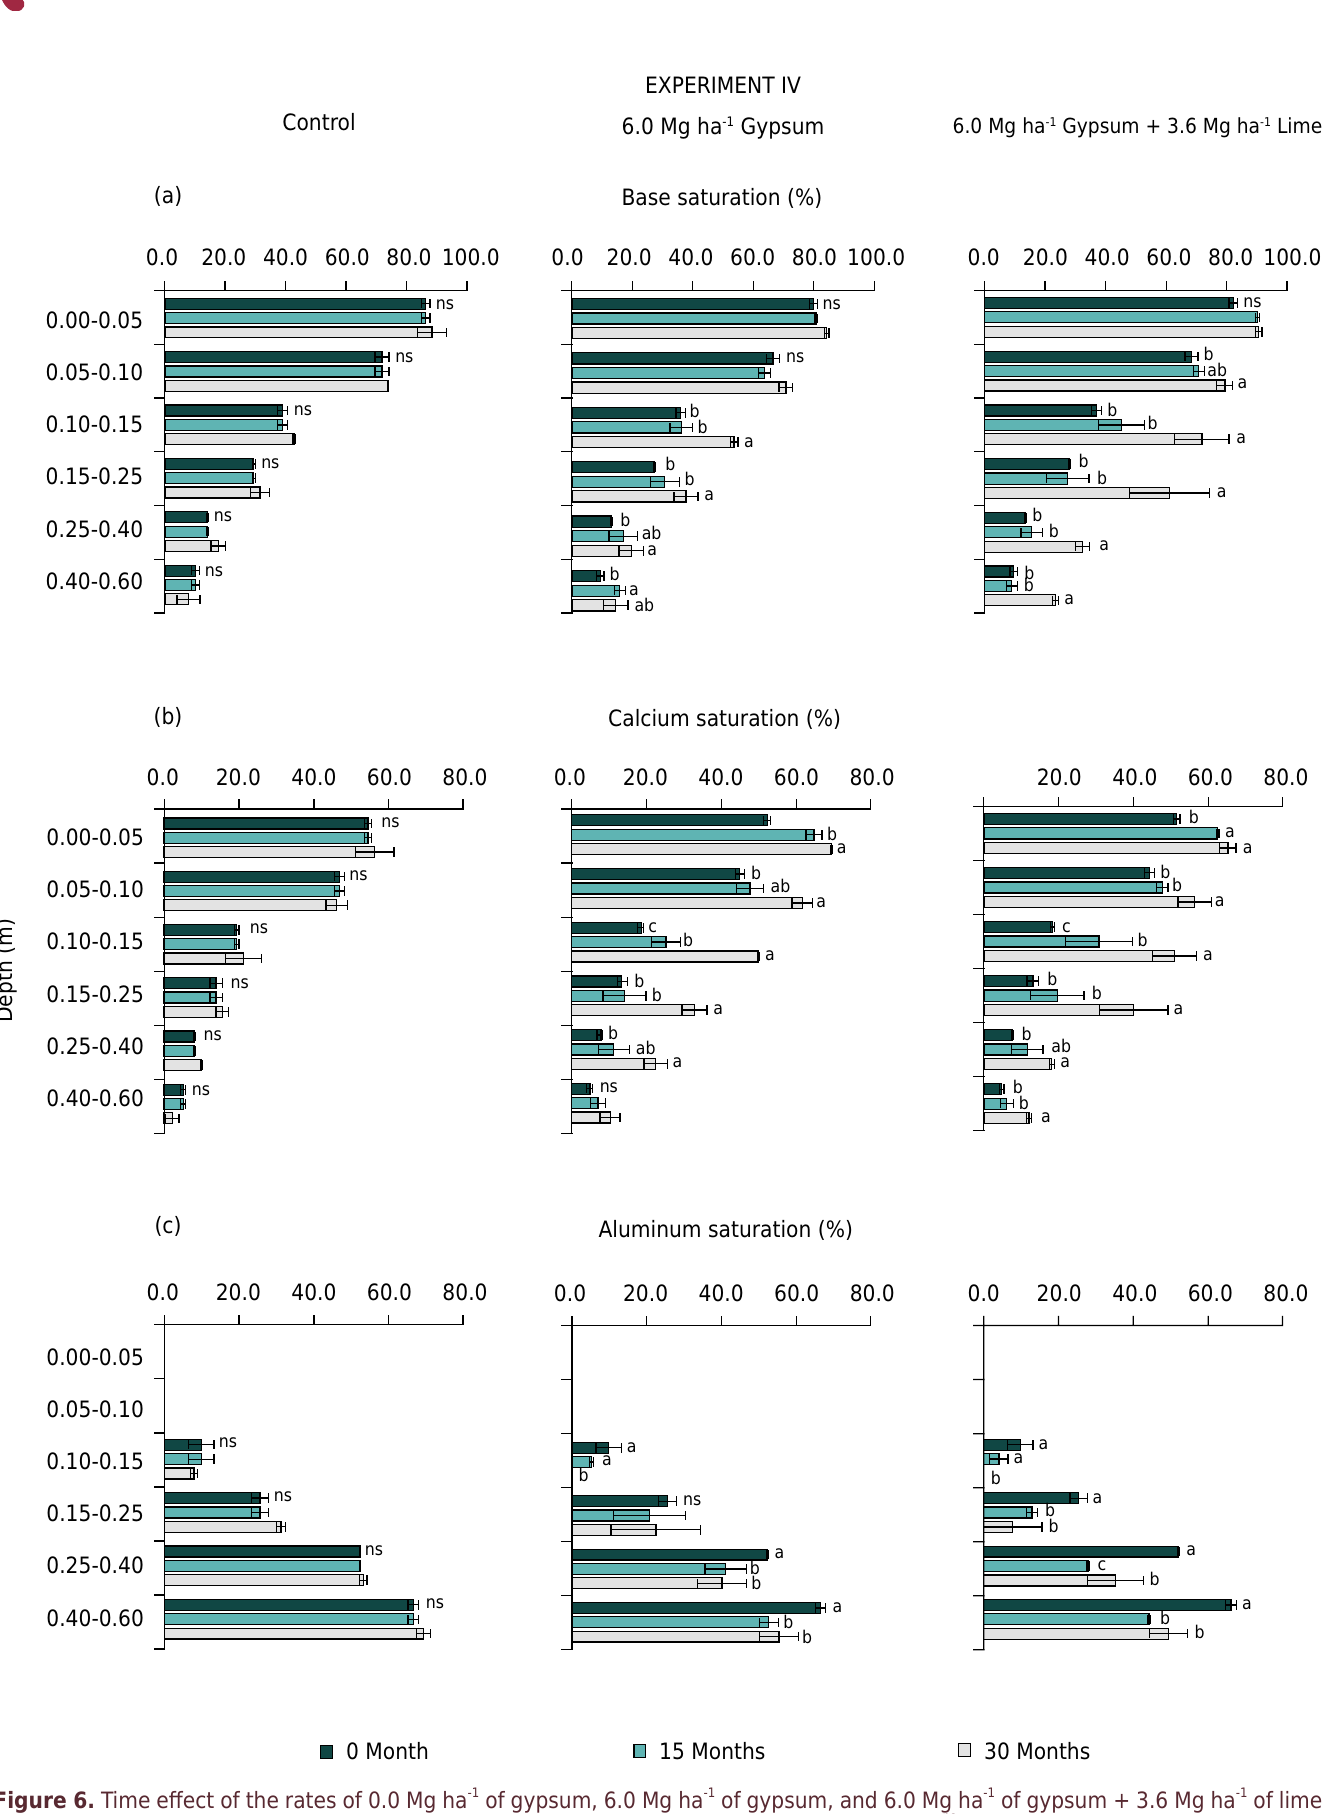
Figure 6. Time effect of the rates of 0.0 Mg ha -1 of gypsum, 6.0 Mg ha -1 of gypsum, and 6.0 Mg ha -1 of gypsum + 3.6 Mg ha -1 of lime on calcium saturation (a), base saturation (b), and aluminum saturation (c) for Experiment IV. ns : not significant at 5 % probability of error; the same letters on the bars for the same depth do not differ significantly at 5 % probability of